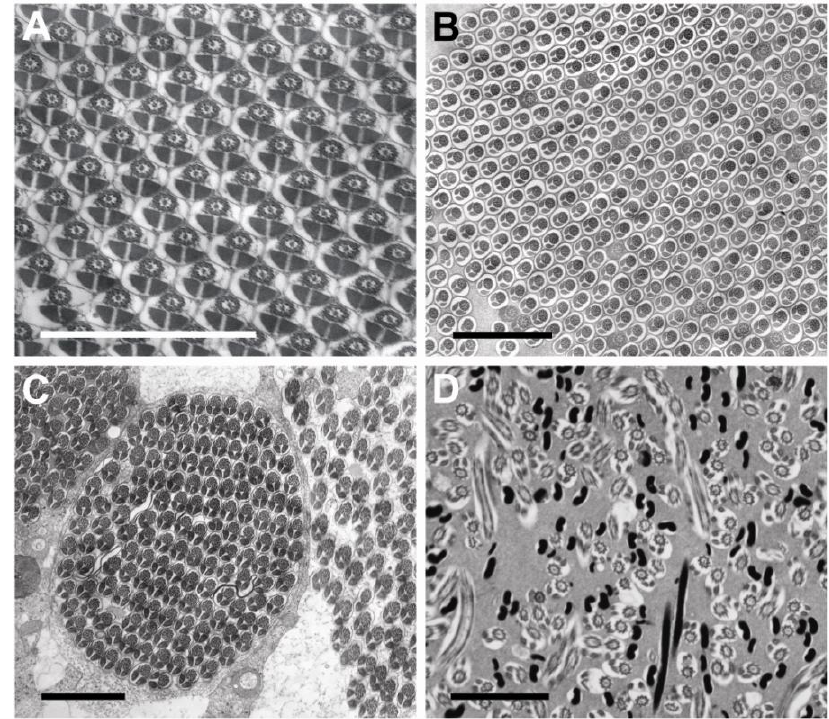
Figure 1. ( A (cid:177) C ) Images show arrays of aligned sperm in coleopteran testes. ( A ) Mylabris variabilis ; ( B ) Zonitis flava ; ( C ) Macrosiagon triscuspidata ; ( D ) Eoxenos laboulbenei. This latter image shows the haphazard alignment of strepsipteran sperm. Sections of sperm flagella are intermixed with sections of sperm nuclei. Sections of nuclei are black. Each scale bar = 2.0 (cid:541) m.